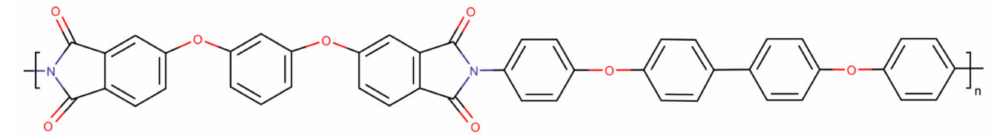
Figure 1. The chemical structure of the considered thermoplastic R-BAPB repeating